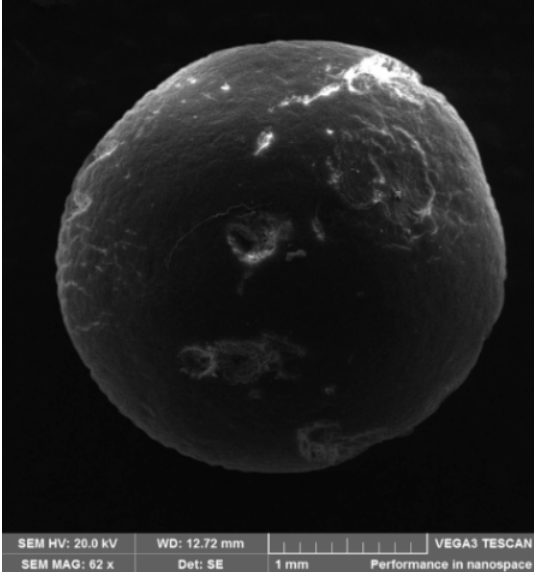
Figure 4. SEM image revealing the non-porous outer layer of the mesoporous neat PAN monolith.